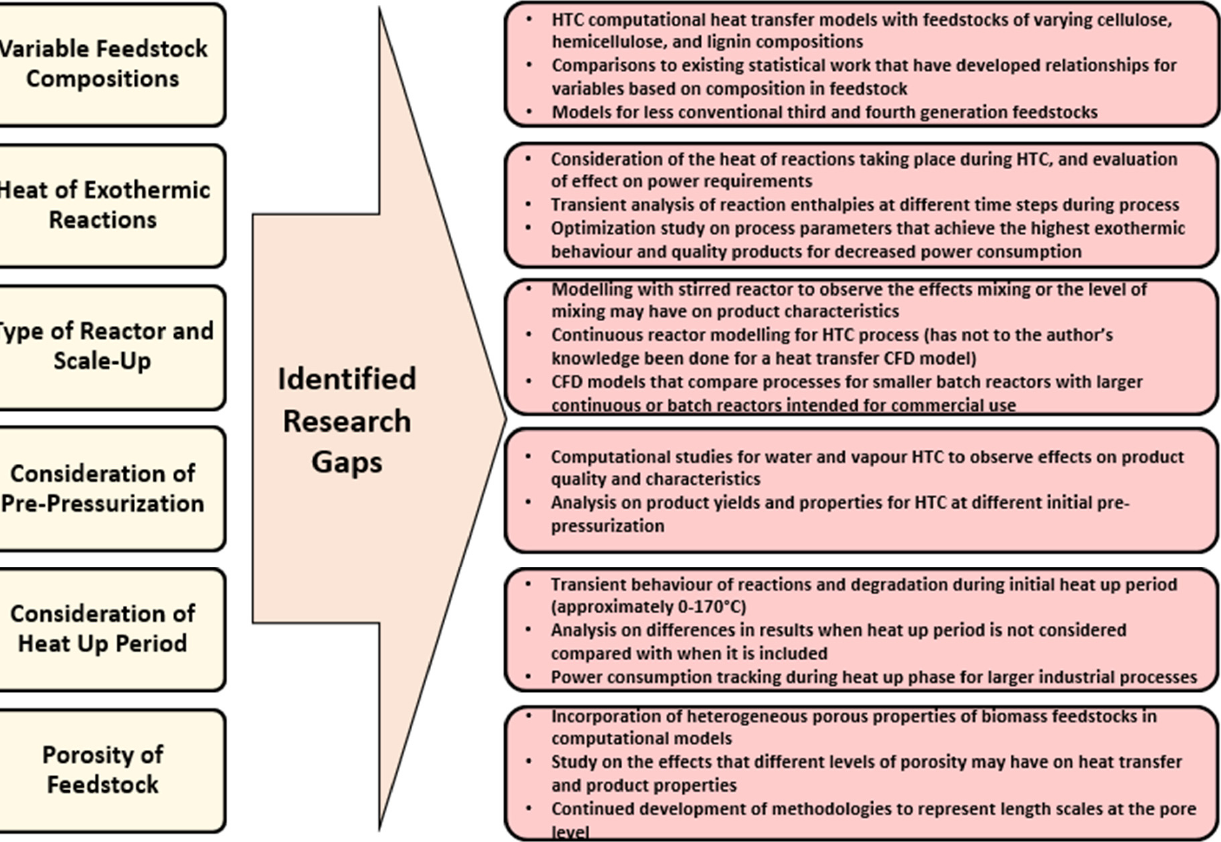
Figure 6. Summary of identified research gaps for six discussed areas of computational HTC models that require further